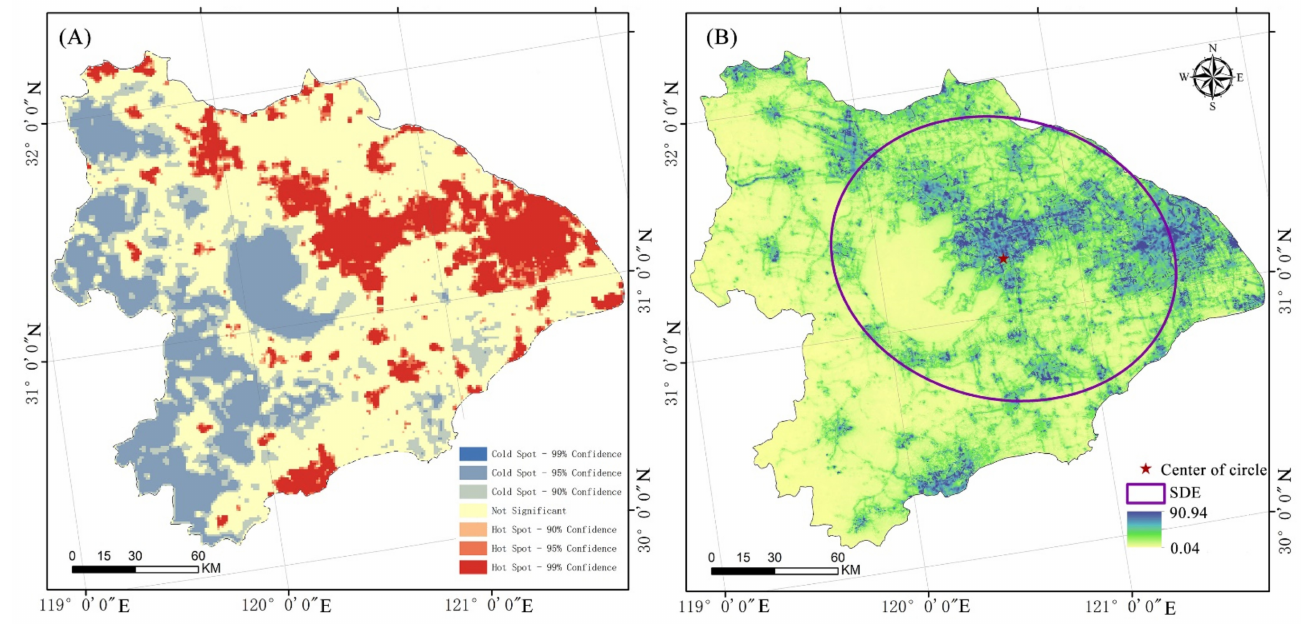
Figure 7. Characteristics of the ecological resistance in Taihu Lake Basin: ( A ) Cold and hot spot analysis; and ( B ) Standard deviation ellipse